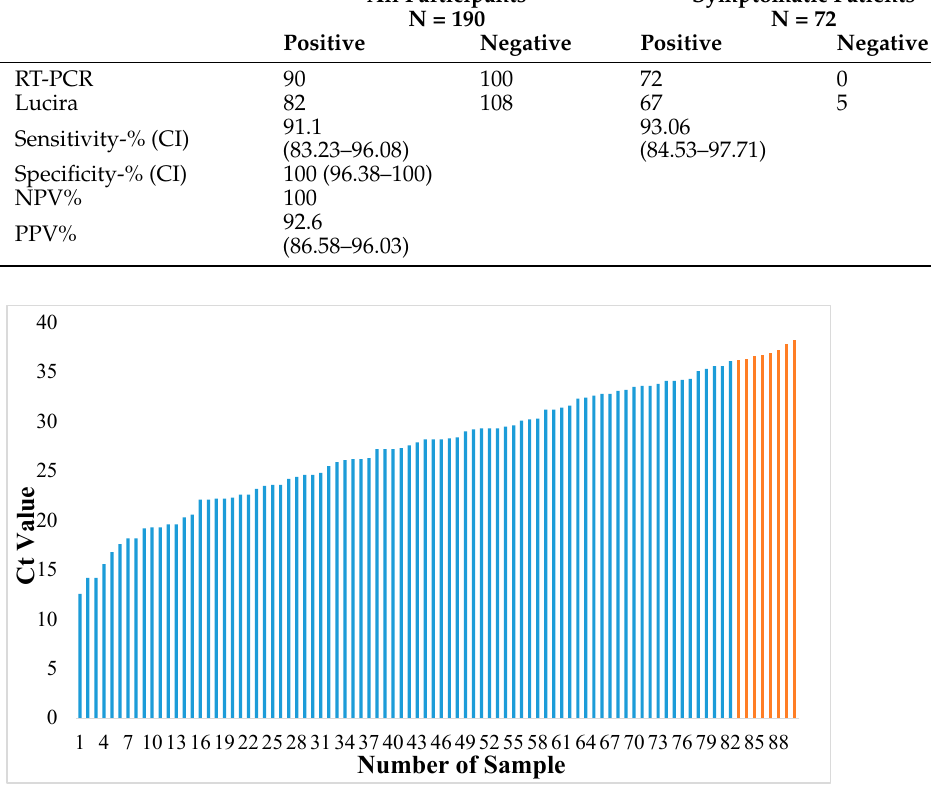
Figure 2. Distribution of Ct values of RT-PCR positive results. Blue bars represent samples of patients for which both the Lucira kit and RT-PCR were positive. Orange bars represent patient samples for which the Lucira kit gave a negative result (Ct value > 36).